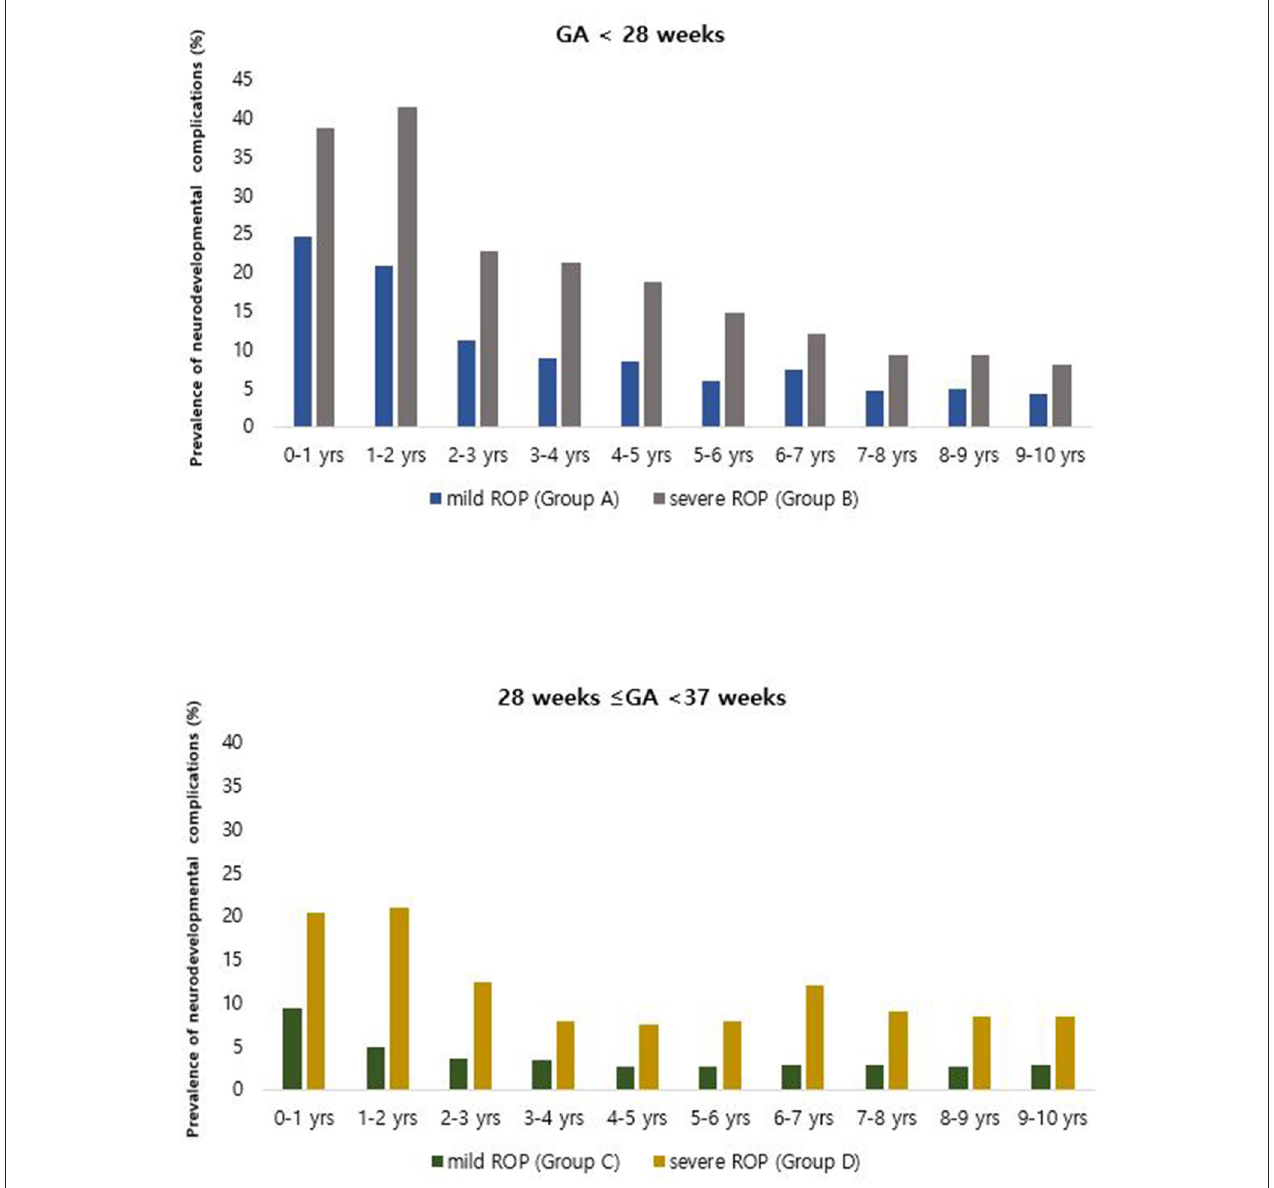
FIGURE 2 | Annual prevalence of overall neurodevelopmental complications among patients born between 2007 and 2008 with retinopathy of prematurity and treated, based on the Korean National Health Insurance Service database throughout the 10-year follow-up